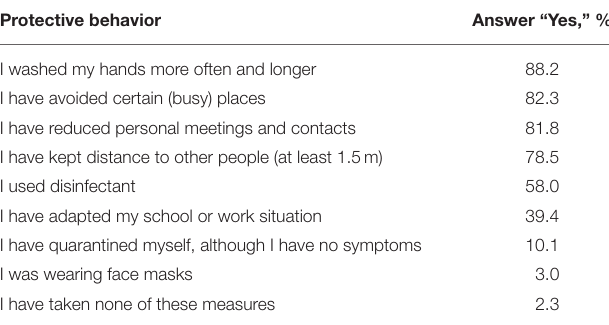
TABLE 2 | Percentage of protective behavior practiced by respondents ( N = 3,186, multiple answers possible). Protective